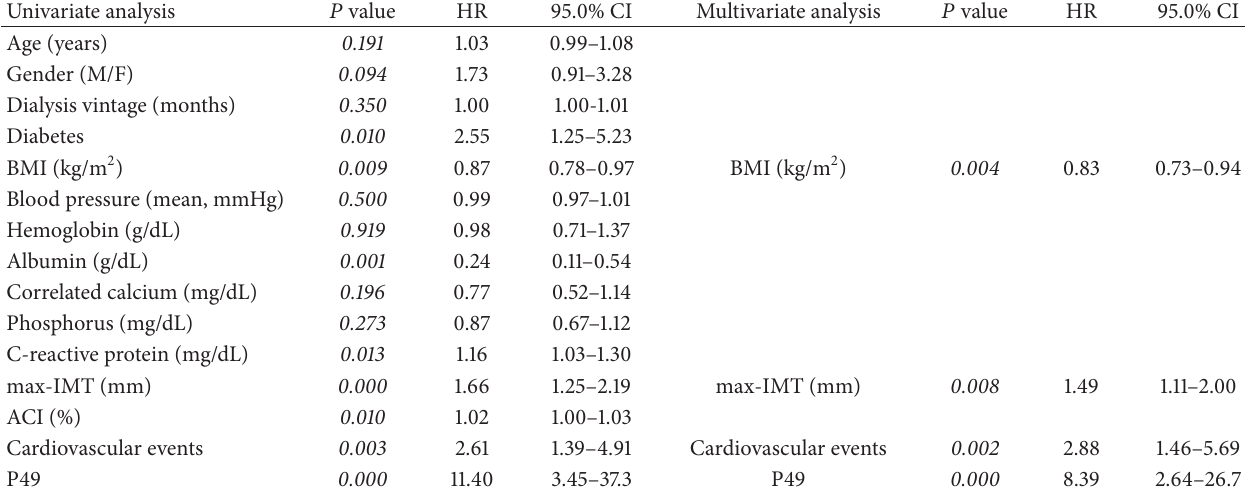
Table 3: Uni- and multivariate Cox regression analysis of biochemical markers and clinical factors associated with overall survival. HR: hazard ratio, CI: confidence interval.